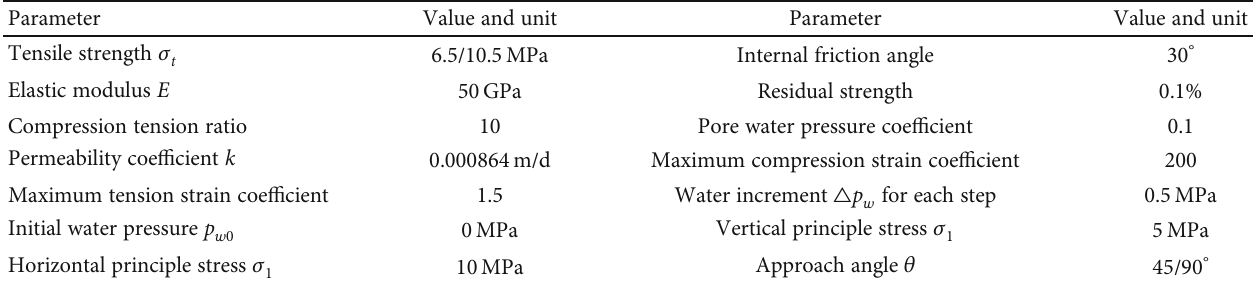
Table 1: Parameters used in the numerical